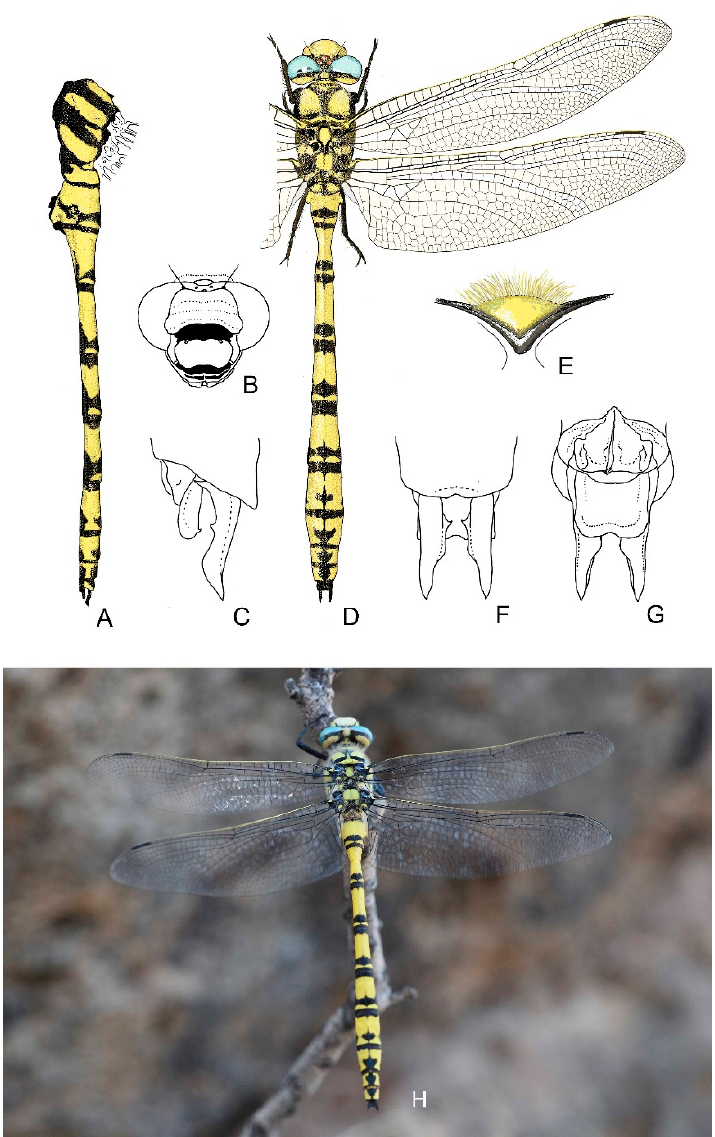
Figure 13. Cordulegaster charpentieri paratype ♂ (yellow form) (RMNH, leg. Thomas Schneider, RMNH.INS.975673, 7 June 2019, Iran, Lost Paradise, Behesht Gomshodeh, Fars, 30.3339° N, 52.1563° E, 1800 m a.s.l.): ( A ): habitus, lateral. ( B ): head, schematically. ( C ): appendages, lateral. ( D ): habitus, dorsal. ( E ): occipital triangle, frontal. ( F ): appendages, dorsal. ( G ): appendages, ventral. ( H ): photo of this paratype (Dietmar Ikemeyer).